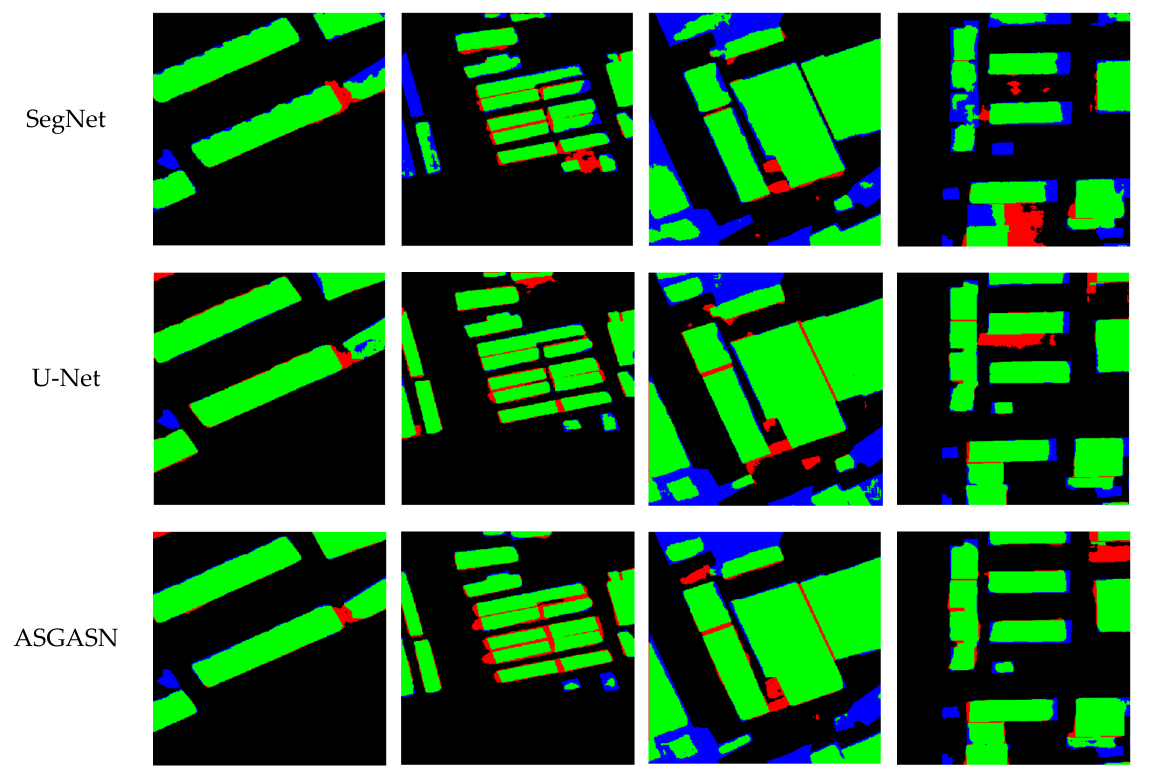
Figure 12. Examples of segmentation results by different models on the CHN dataset. The green, red, blue, and black pixels of the maps represent the true positive, false positive, false negative, and true negative predictions, respectively. Table 3. Quantitative comparison with the state-of-the-art models on the CHN dataset. The highest value for each metric is marked as bold.